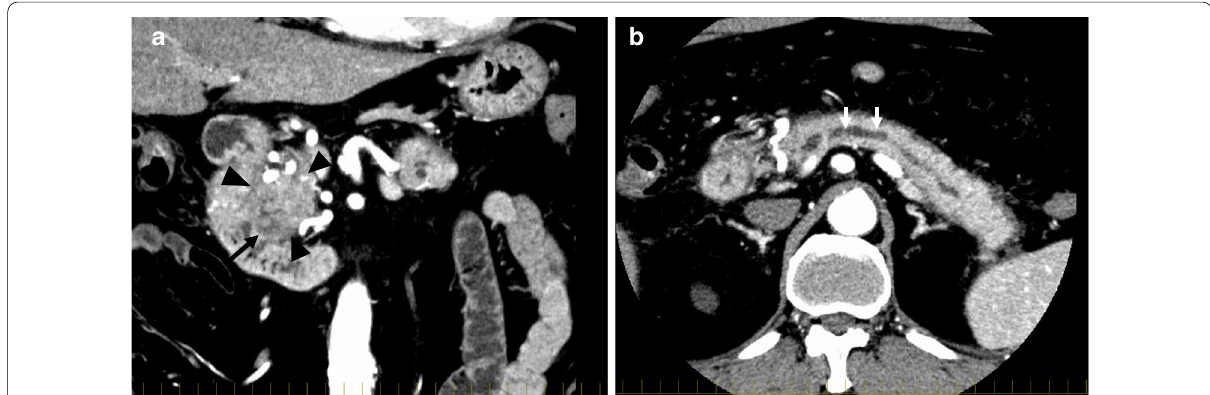
Fig. 1 Contrast-enhanced CT. a A 40-mm mass with an irregular margin was detected in the pancreatic head (arrowhead), and a low-density area with 20 mm in diameter was observed on the duodenal side of the mass (arrow). b An expanding main pancreatic duct was detected with a 9-mm diameter at the distal side of the tumor